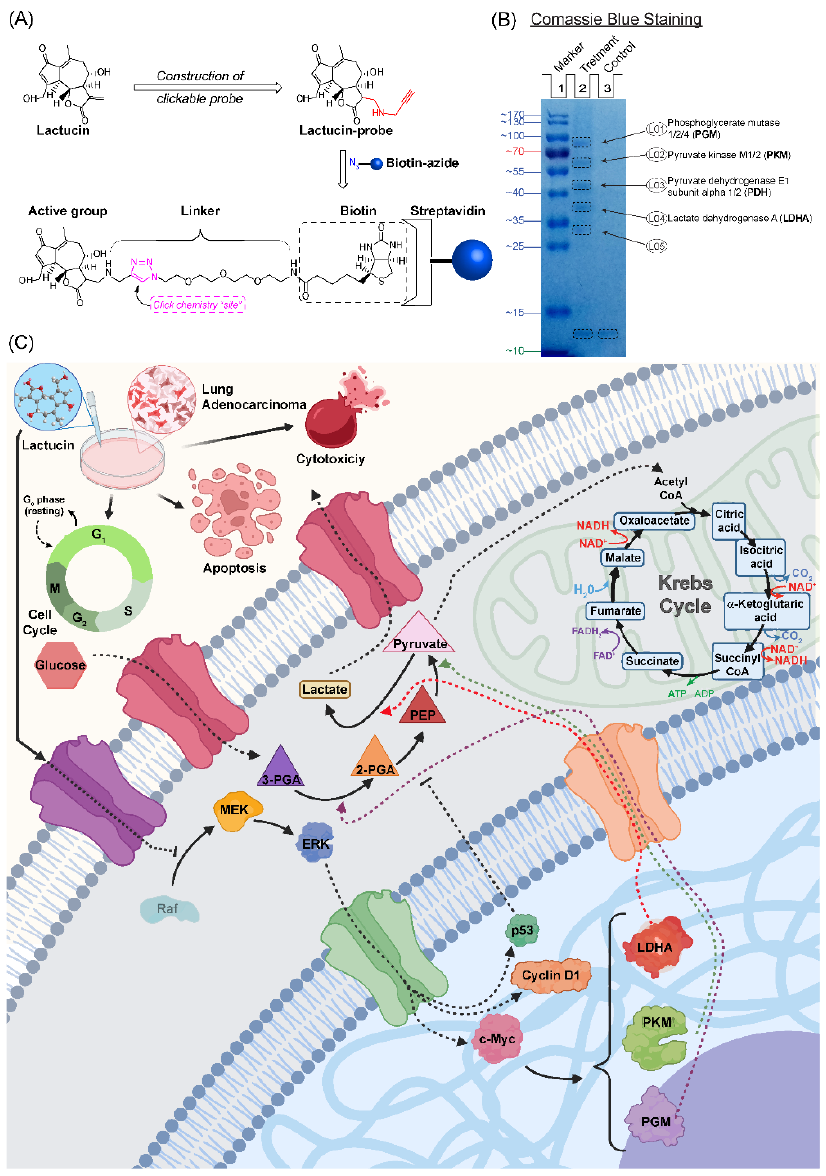
Figure 6. Lactucin downregulates Raf-MEK-ERK by inhibiting upstream trans-membrane peptides. Biotinylated Lactucin probes bound to targeted proteins are immobilized to streptavidin agarose through biotin, azide, and a linker molecule ( A ). Visualizing SDS resolved A549 protein lysate showed biotinylated Lactucin probe binds five peptides ( B ). Lactucin downregulates A549 lung adenocarcinoma cells Raf-MEK-ERK pathway and Central Carbon Metabolism in Cancer cells (C) .